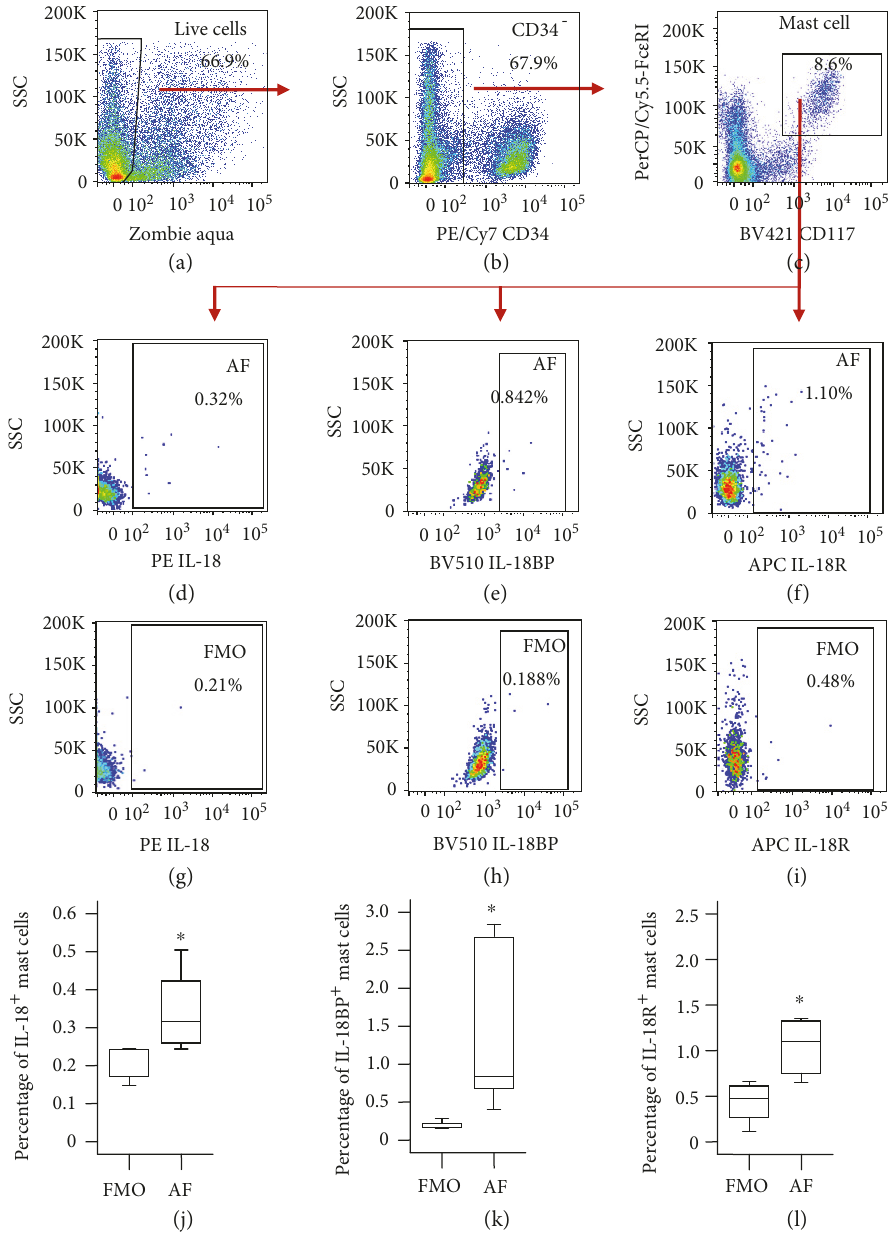
Figure 2: Expression of IL-18, IL-18 receptor (IL-18R), and IL-18 binding protein (BP) in mast cells from human skin tissue of healthy subjects. (a) – (c) show gating strategy of mast cells; (d) – (f) show percentage of IL-18, IL-18BP, and IL-18R expressing mast cells; (g) – (i) show fl uorescence minus one (FMO) of IL-18, IL-18BP, and IL-18R expressing mast cells; and (j) – (l) are percentage values of IL-18, IL-18BP, and IL-18R expressing mast cells in skin tissue. Data shown are the median (range) value from 6 di ff erent donors. ∗ P < 0 05 in comparison with FMO (paired Mann – Whitney U test). AF: all fl